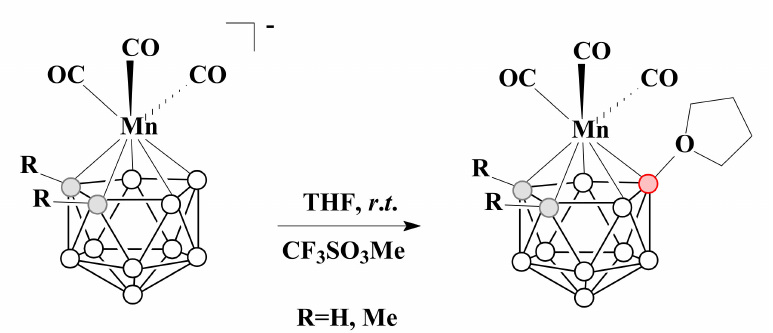
Scheme 22. The synthetic route to [3,3,3-(CO) 3 -3-Mn(8-(CH 2 ) 4 O-1,2-C 2 B 9 H 10 )] and [3,3,3-(CO) 3 -3- Mn(8-(CH 2 ) 4 O-1,2-Me 2 -1,2-C 2 B 9 H 8 )]. It was shown that the reaction of tetrahydrofuran derivative of the tricarbonyl man- ganese complex [3,3,3-(CO) 3 -3-Mn(8-(CH 2 ) 4 O-1,2-C 2 B 9 H 10 )] with NEt 4 I in THF under reflux conditions resulted in the opening of the tetrahydrofuran cycle with the formation of